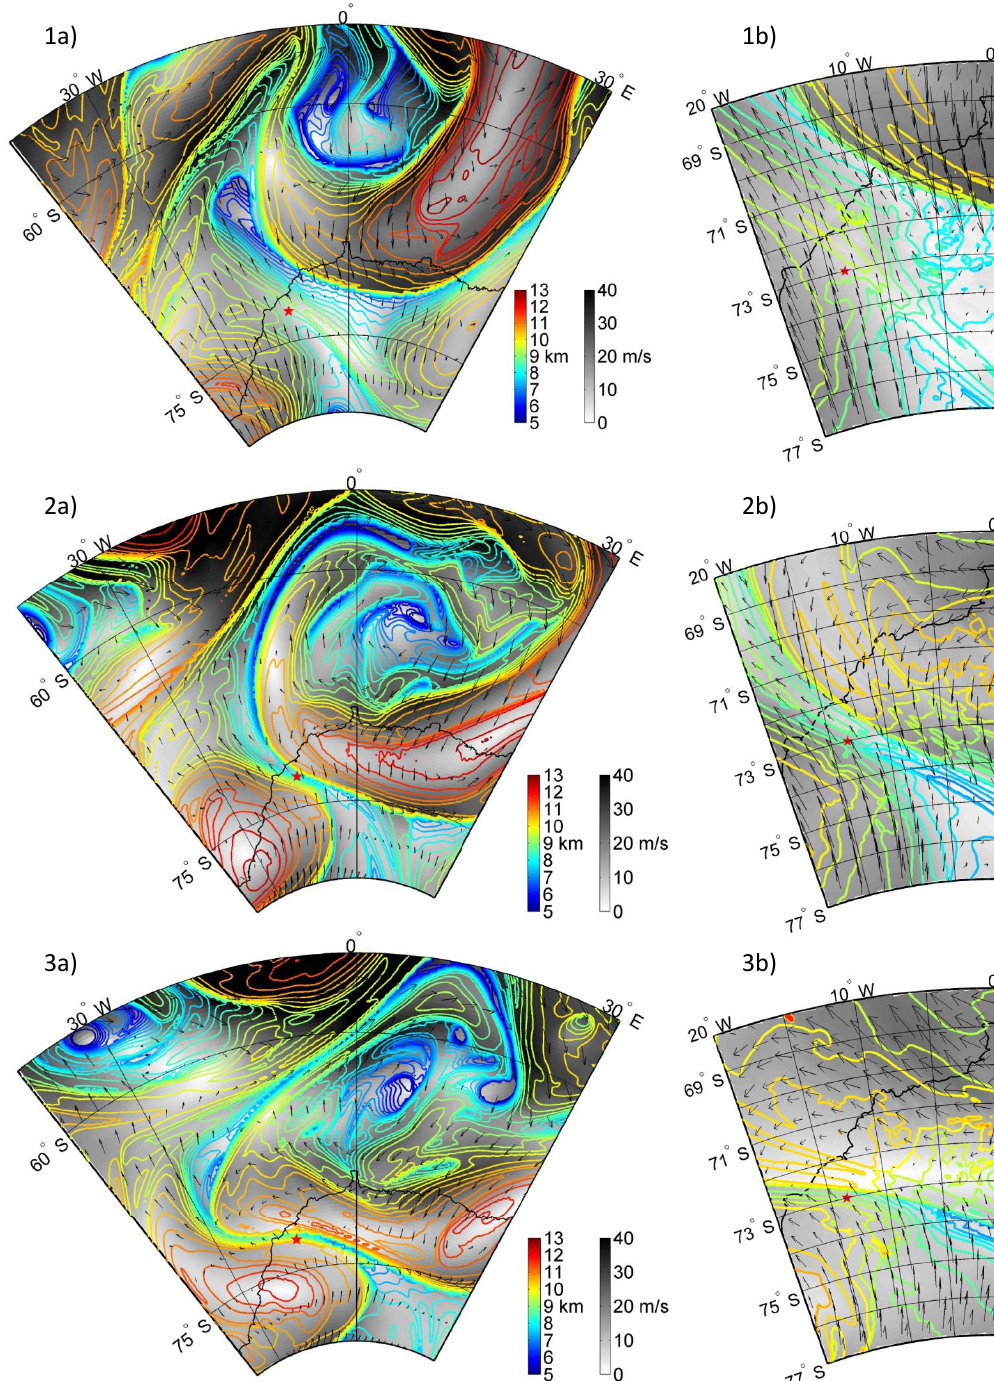
Fig. 4. Tropopause maps – height (km), wind speed (ms − 1 ) and wind direction at the dynamic tropopause ( − 2pvu level of potential vorticity) from 28 December 2010, 06:00UTC (1), 29 December 2010, 00:00UTC (2) and 29 December 2010, 12:00UTC (3) from ECMWF operational analysis (a) and WRF model (b) . Map grids used are as seen in Fig. 2b – ECMWF model and Fig. 2c – WRF model. Red star – position of MARA